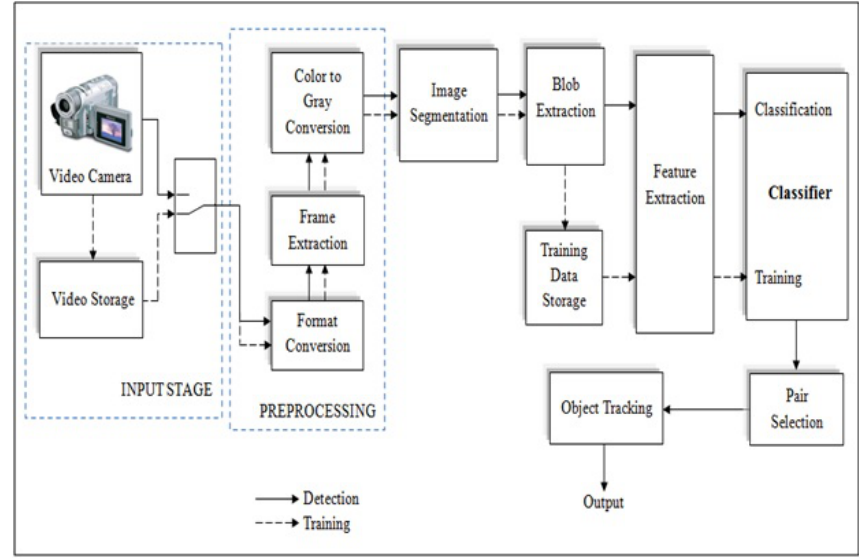
Figure 1. Block diagram of the detection